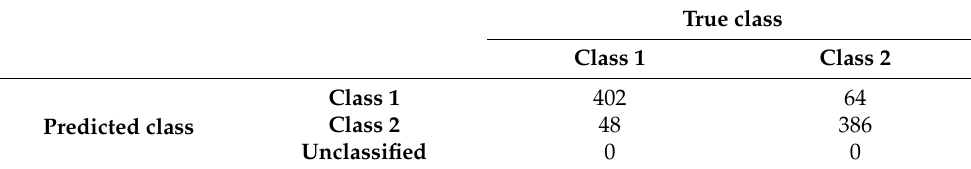
Table 12. Total confusion matrix of 10-fold cross-validation of classification results with the DNRS with 810 samples of training data using attributes 4, 6, and 7 of the Raisin